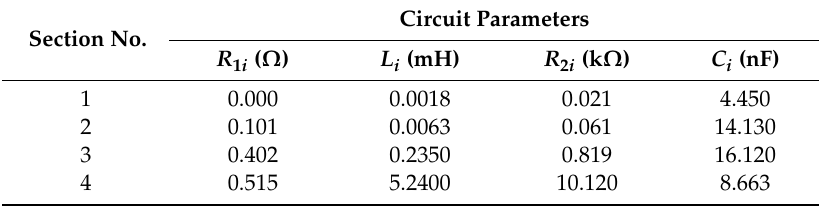
Table 4. Circuit parameters determined by the proposed approach. Section No. Section